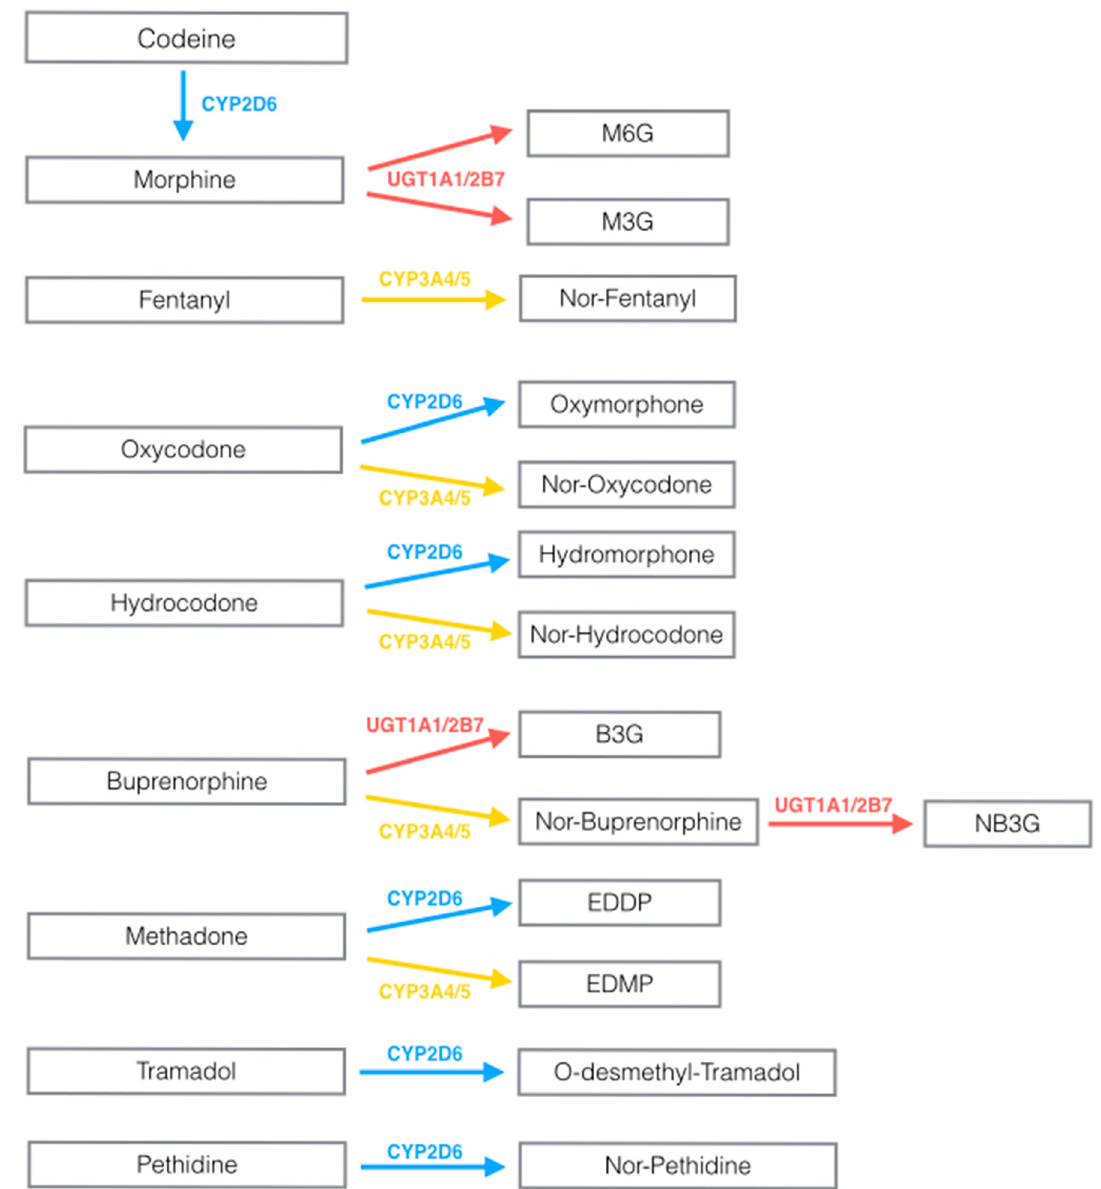
Figure 1. Schematic pharmacokinetics (PK) pathways of opioids commonly used in clinical practice. EDDP: 2-ethylidene-1,5-dimethyl-3,3-diphenylpyrrolidine; EMDP: 2-ethyl-5-methyl-3,3- diphenyl-1-pyrroline; B3G: buprenorphine-3-glucoronide; NB3G: norbuprenorphine-3-glucoronide. CYP: Cytochrome P; UGT: UDP-glucuronosyl-transferase. Colors are used to identify specific enzymes. Blue: CYP2D6, red: UGT, yellow: CYP3A4/5. 3.1.1. Cytochrome P-450 Genetic Variability and Opioid